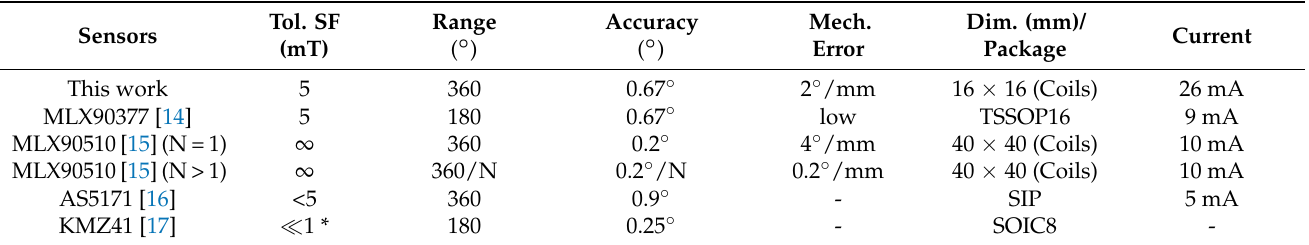
Table 3. Comparison with other existing automotive position sensors. Note that “N” is the periodicity of the inductive sensor. The dimensions do not take into account the